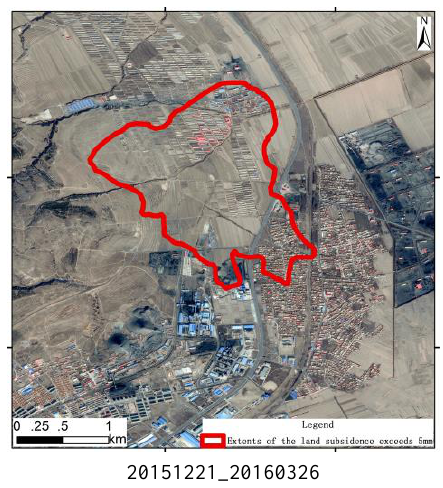
Fig.5 enlarged subsidence